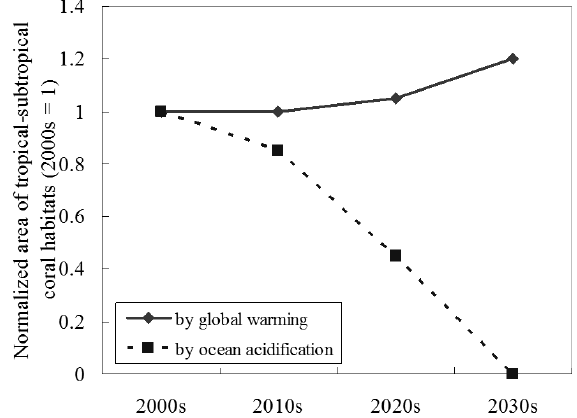
Fig. 5. Projected temporal changes in the normalized surface area of tropical/subtropical coral habitats in 2000s through 2030s (as of 2000s=1). A solid line shows the area increased by SST warm- ing due to global warming. A dotted line denotes that decreased by (cid:127) arag decrease due to ocean